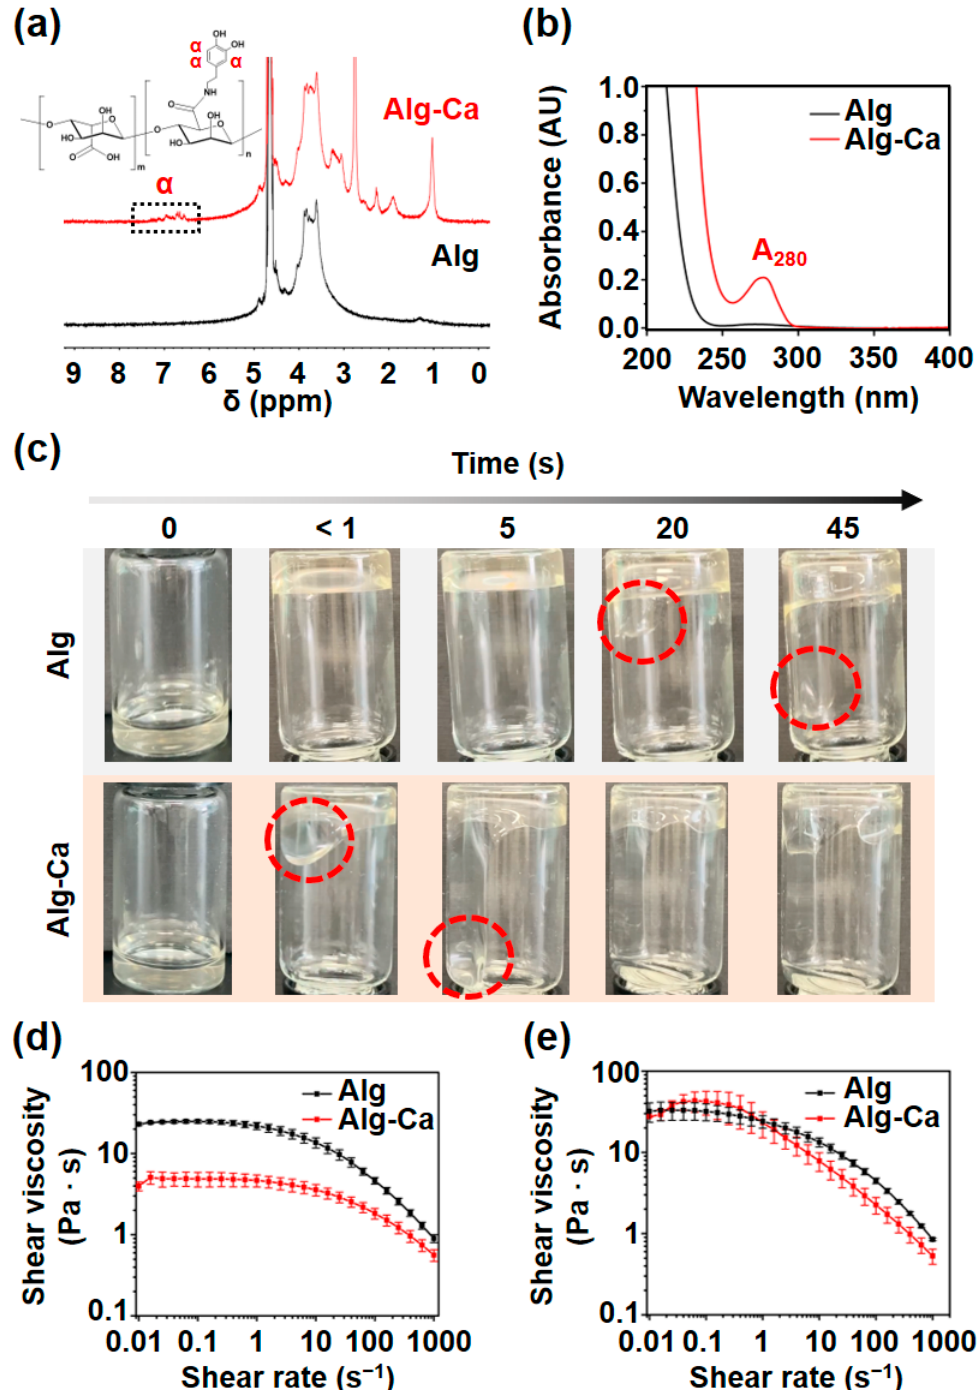
Figure 2. Physicochemical characteristics of Alg-Ca compared to Alg. ( a ) 1 H NMR spectrum of Alg (black) and Alg-Ca (red). Alg-Ca 1 H NMR spectrum exhibited proton peaks that indicate the appearance of the catechol α proton. ( b ) UV–vis spectrum of Alg (black) and Alg-Ca (red) aqueous solution. ( c ) Viscosity comparison of Alg (top) and Alg-Ca (bottom) solution (3 w / v % in DW) in 10 mL vial. Red dashed lines indicate the solution flowing down. Shear viscosity of Alg (black) and Alg-Ca (red) in DW ( d ), and in HEPES buffer (25 mM, pH 7.4) ( e ) depending on shear rate (0.01–1000 s − 1 ) (n = 3, mean ± SD).